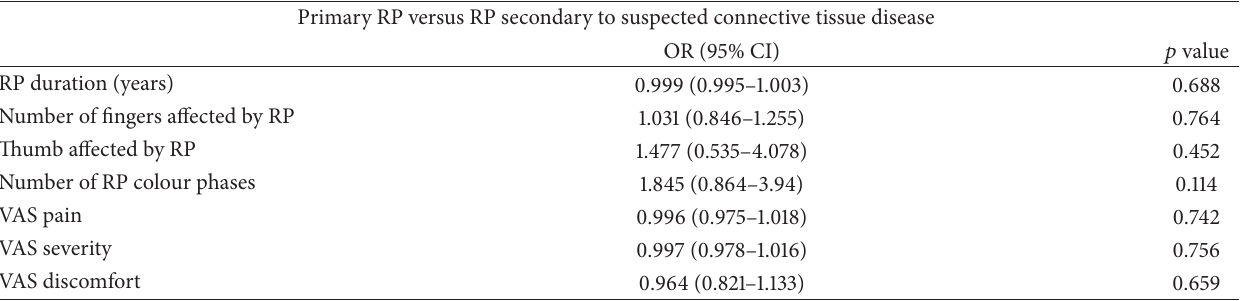
Table 2: Univariate analysis of primary RP versus RP secondary to suspected connective tissue disease. All the variables included as mandatory in the classification criteria of primary RP (i.e., ANA and capillaroscopy that must be negative) were excluded from the analysis. Primary RP versus RP secondary to suspected connective tissue